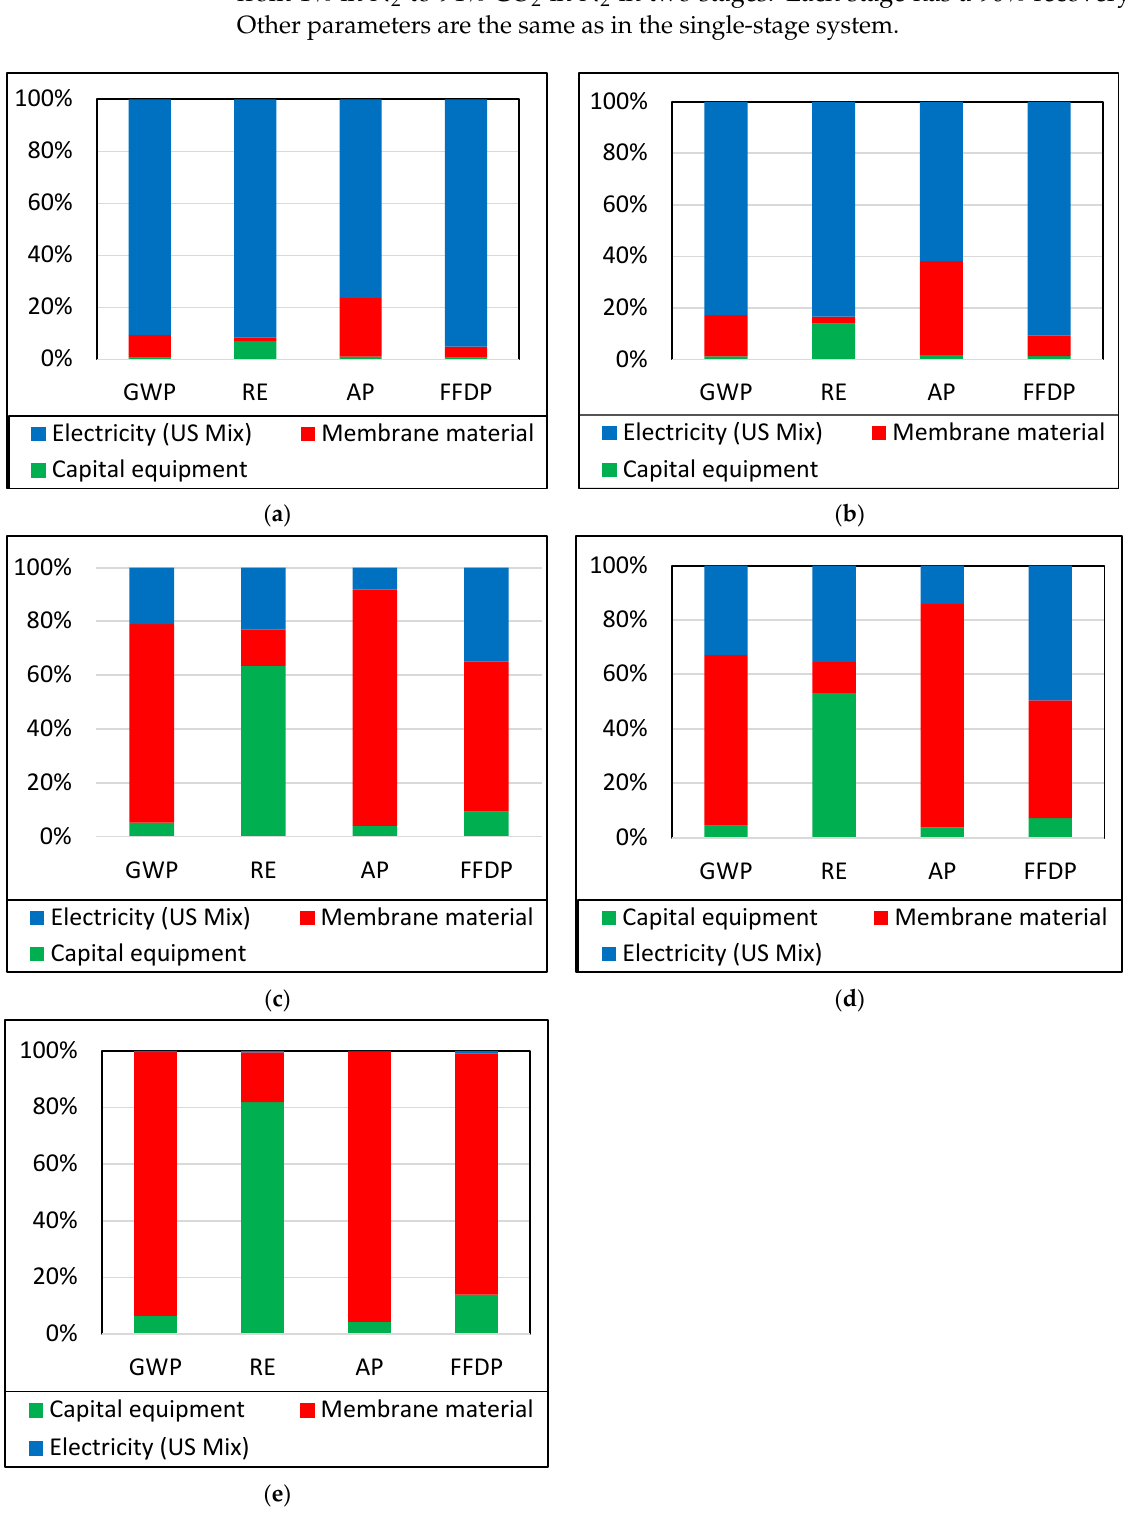
Figure 4. Analysis of contributions of the two-stage CO 2 enrichment process with ( a ) MEEP, ( b ) MEEP/CN, ( c ) Pebax LE, ( d ) Pebax HE, and ( e ) Pebax ZIF-8